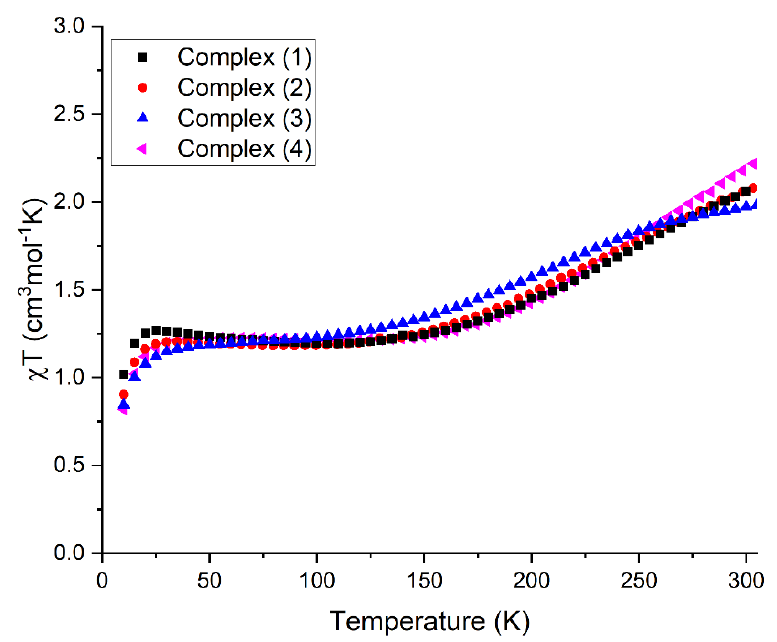
Figure 2. Temperature dependence of X M T for the Mn(III) complexes 1 – 4 . Data collected in an applied DC field of 0.5 T.